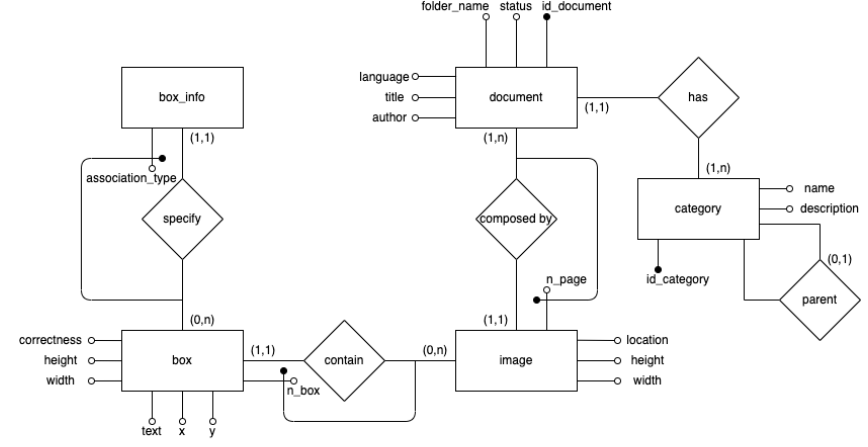
Figure 4. Data management: entity-relationship diagram for database conceptual